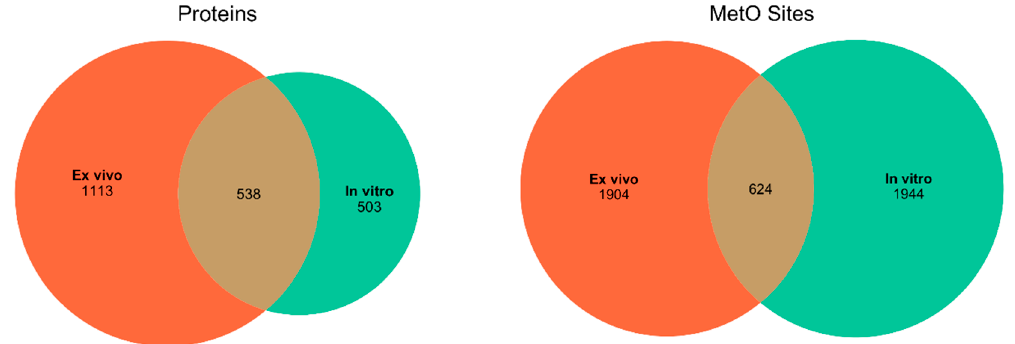
Figure 1. Distribution of the number of proteins and MetO sites found in ex vivo and in vitro studies. Left panel: distribution of the number of di ff erent MetO-containing proteins. Right panel: distribution Left panel: distribution of the number of different MetO-containing proteins. Right panel: distribution of the number of MetO of the number of MetO sites.